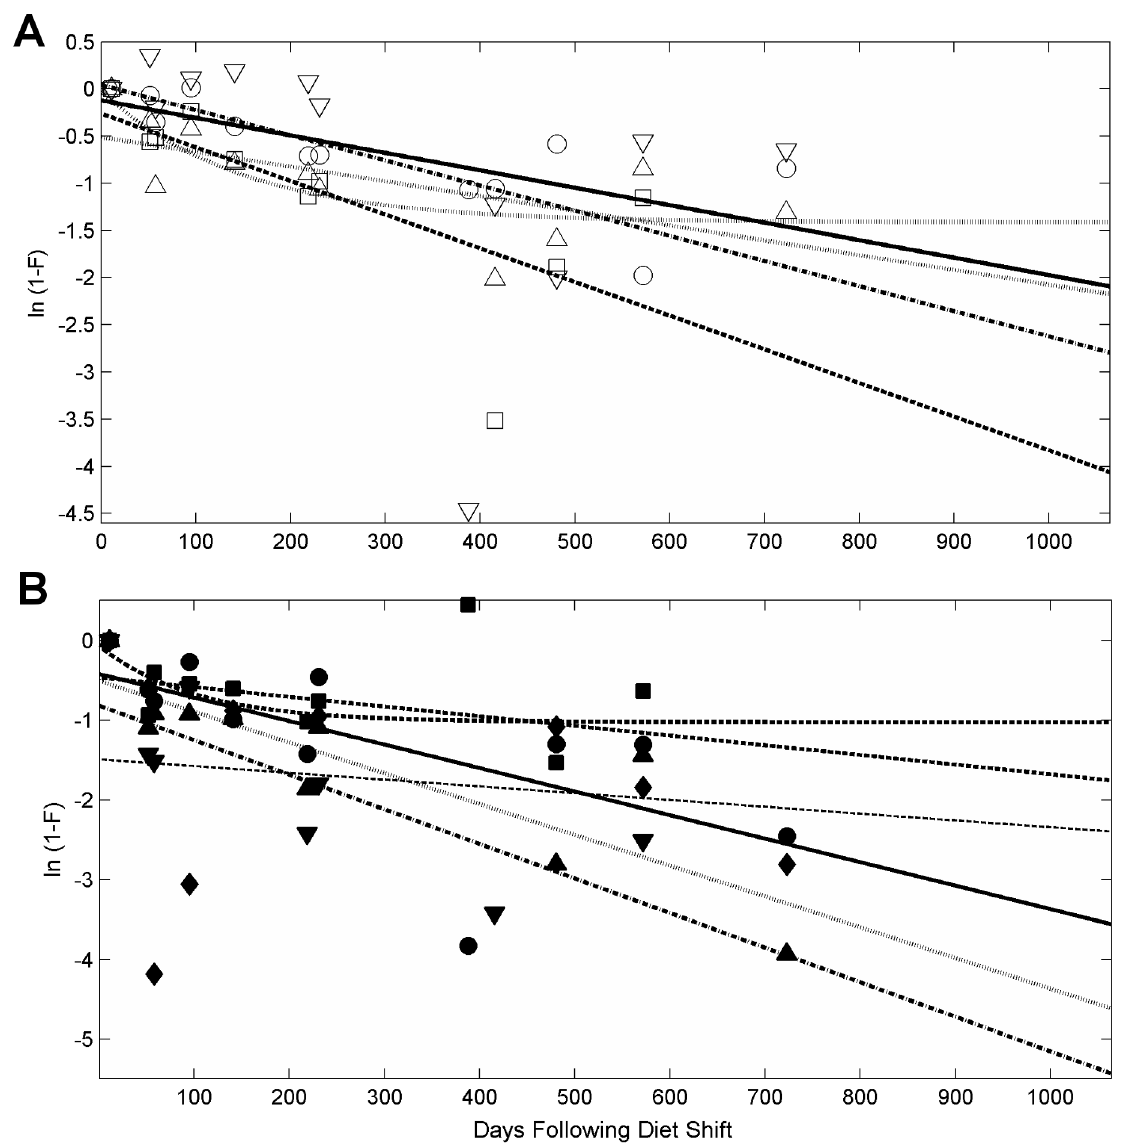
Figure 3. Reaction-progress variables for isotopic changes of amino acids in captive Pacific bluefin tuna ( Thunnusorientalis ). Changes in isotopic composition over time of A) four source amino acids, glycine (unfilled circle), lysine (unfilled square), serine (unfilled triangle), threonine (unfilled inverted triangle), and B) five trophic amino acids - alanine (filled circle), glutamic acid (filled square), leucine (filled triangle), proline (filled inverted triangle), and valine (unfilled diamond). Lines represent best fit for a linear fit model, with additional exponential fit models for proline and serine.